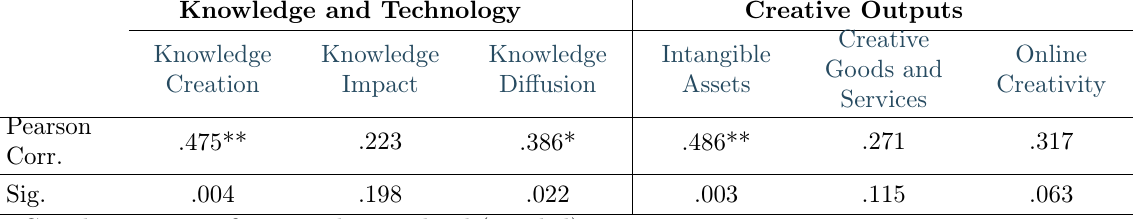
Table 3. Correlations – Change in Innovation Outputs Score with Change in Global Innovation Index Score (N=35) Knowledge and Technology Creative Outputs Creative Knowledge Knowledge Knowledge Intangible Online Goods and Creation Impact Diffusion Assets Creativity Services Pearson